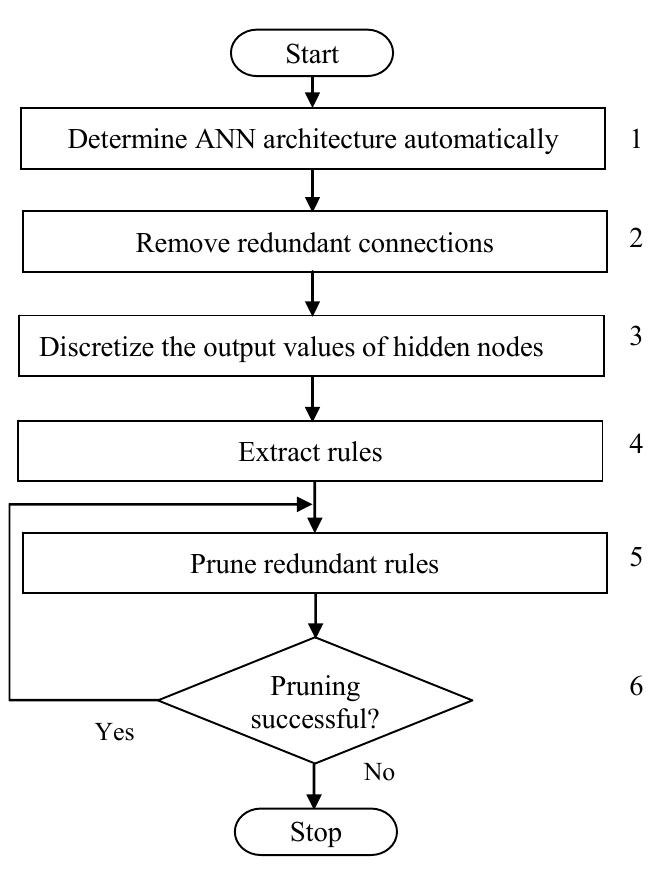
Figure 2. Flow chart of the proposed ESRNN